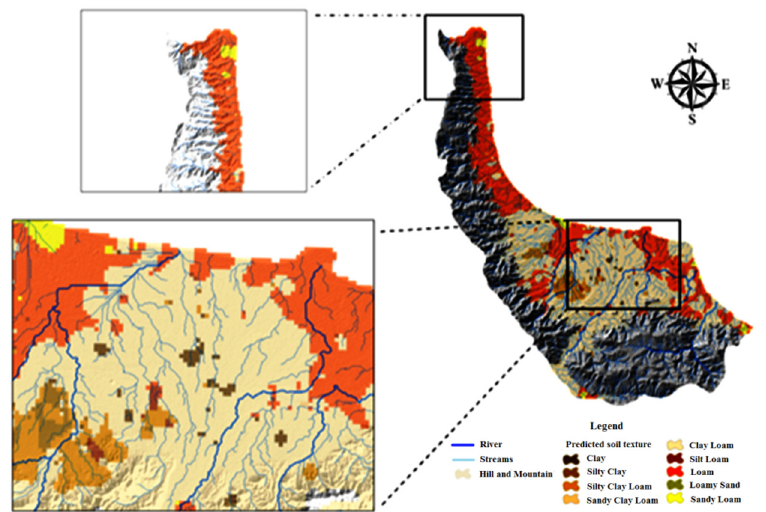
Figure 8. Predicted dominant USDA soil textural class map of Guilan Province.